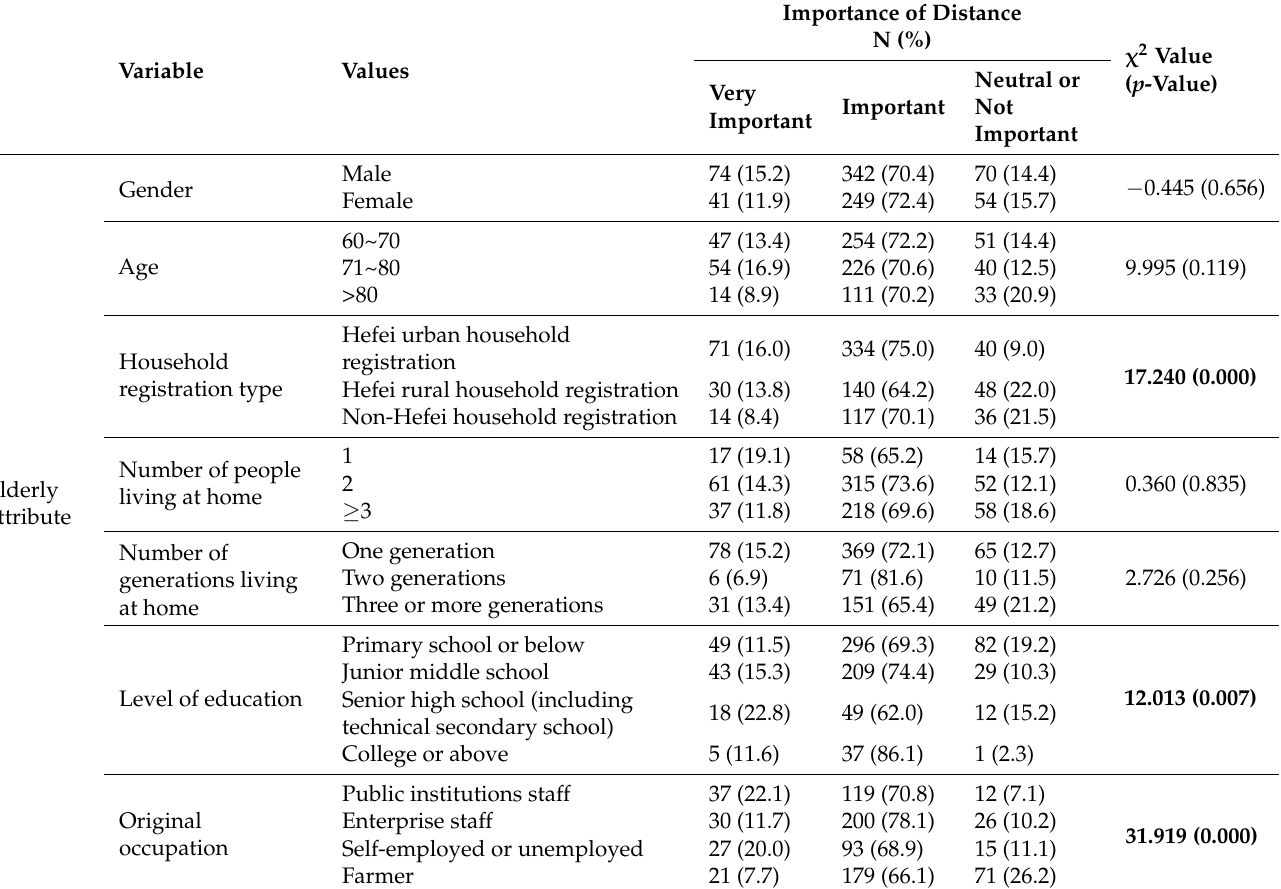
Table 4. Chi-squared test of elderly attributes and their preference for